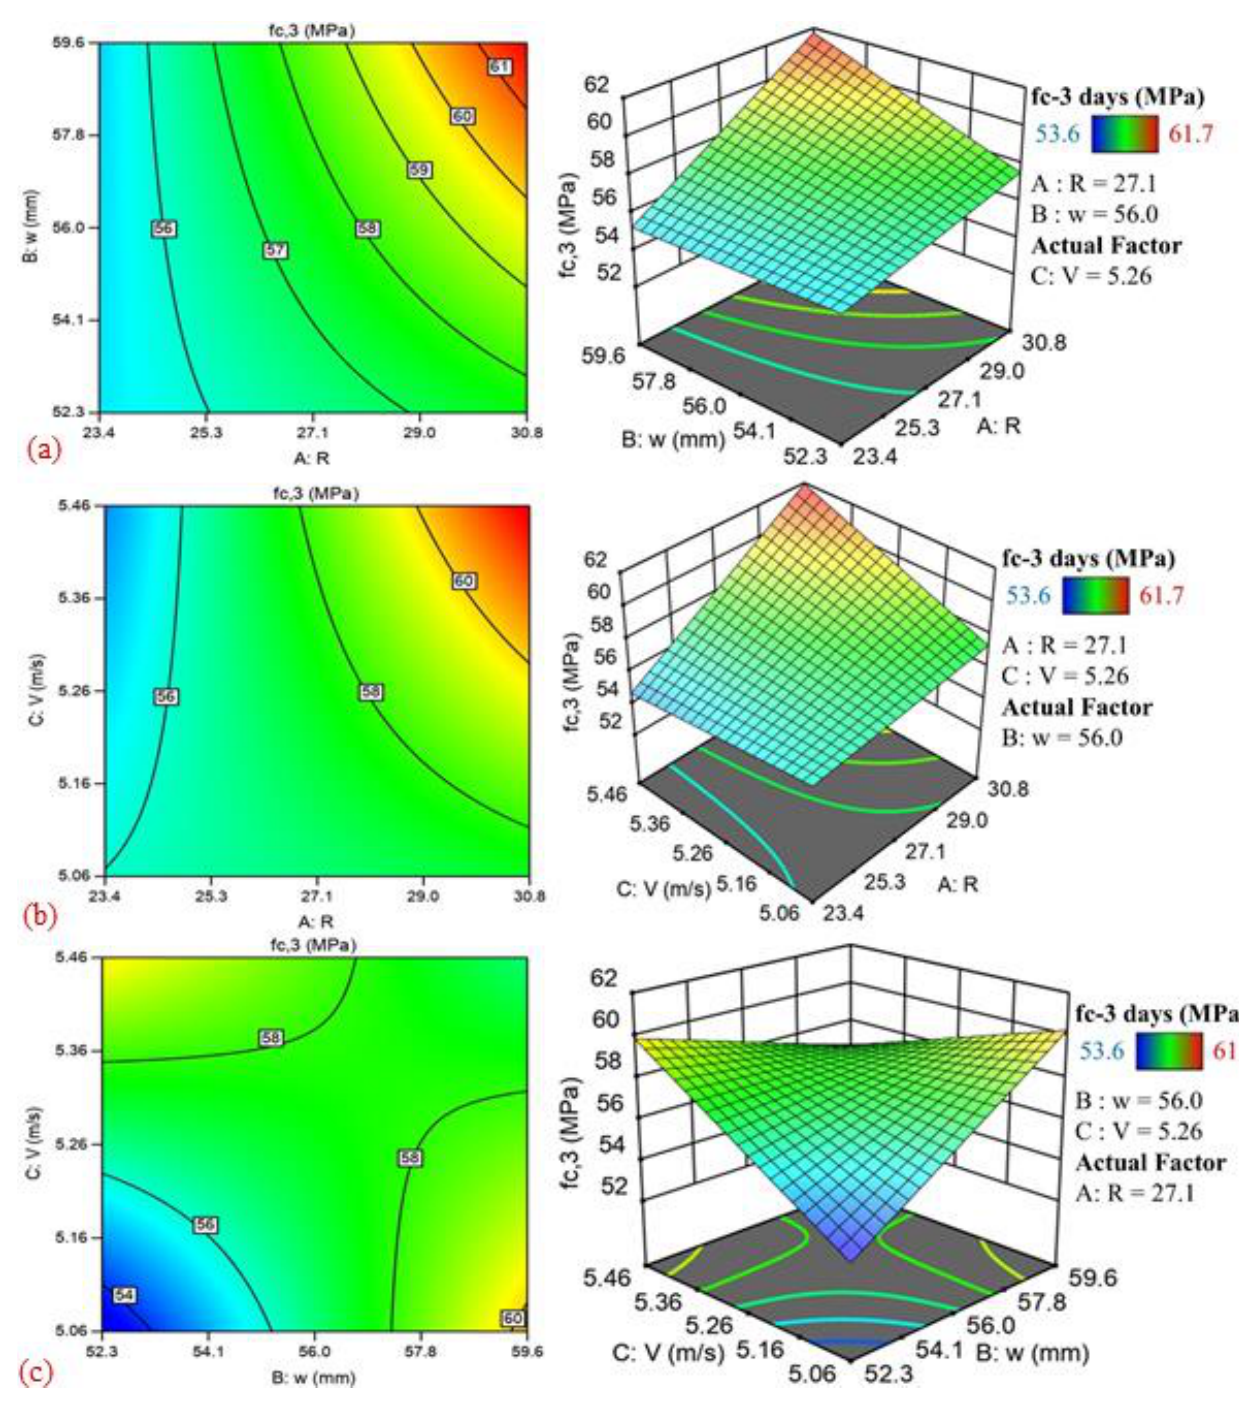
Figure 6. The effect of model 4 on early-age strength: ( a ) Model 1, ( b ) Model 2, and ( c ) Model 3.